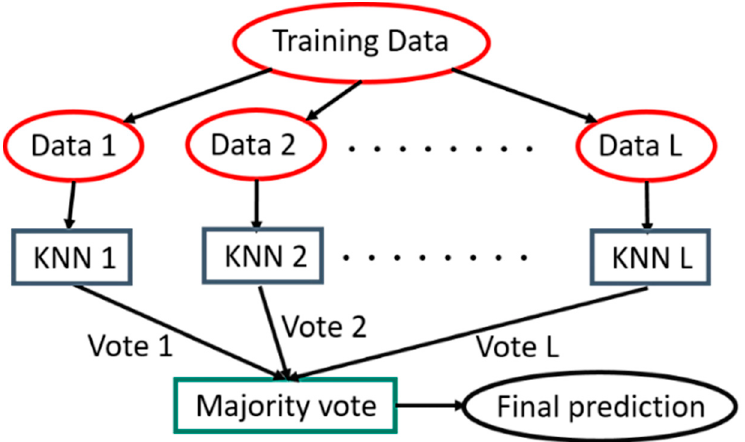
Figure 8. Subspace KNN architecture.